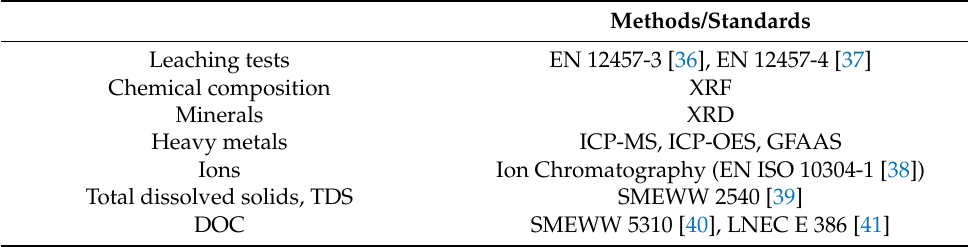
Table 2. Methods/standards used in the studies